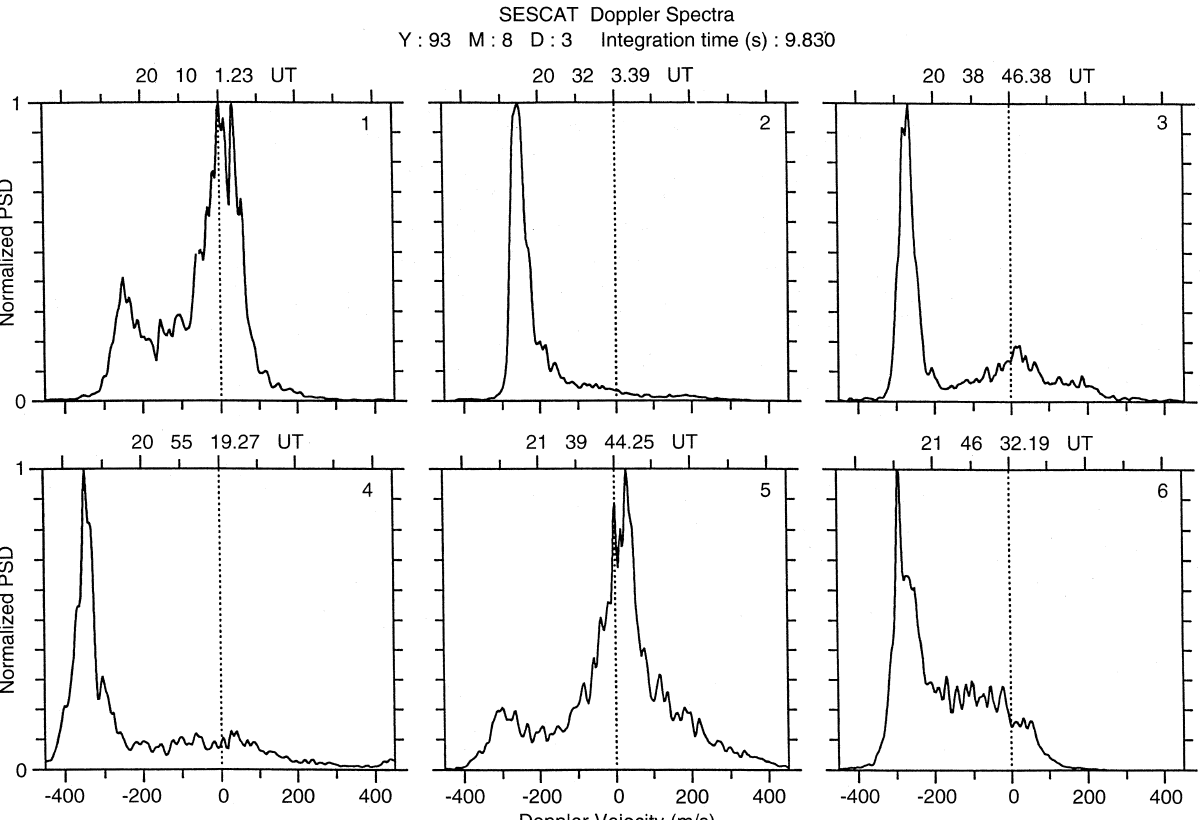
E -region plasma. These echoes are mixed with a broad spectrum at lower velocities, probably because of spatial and/or